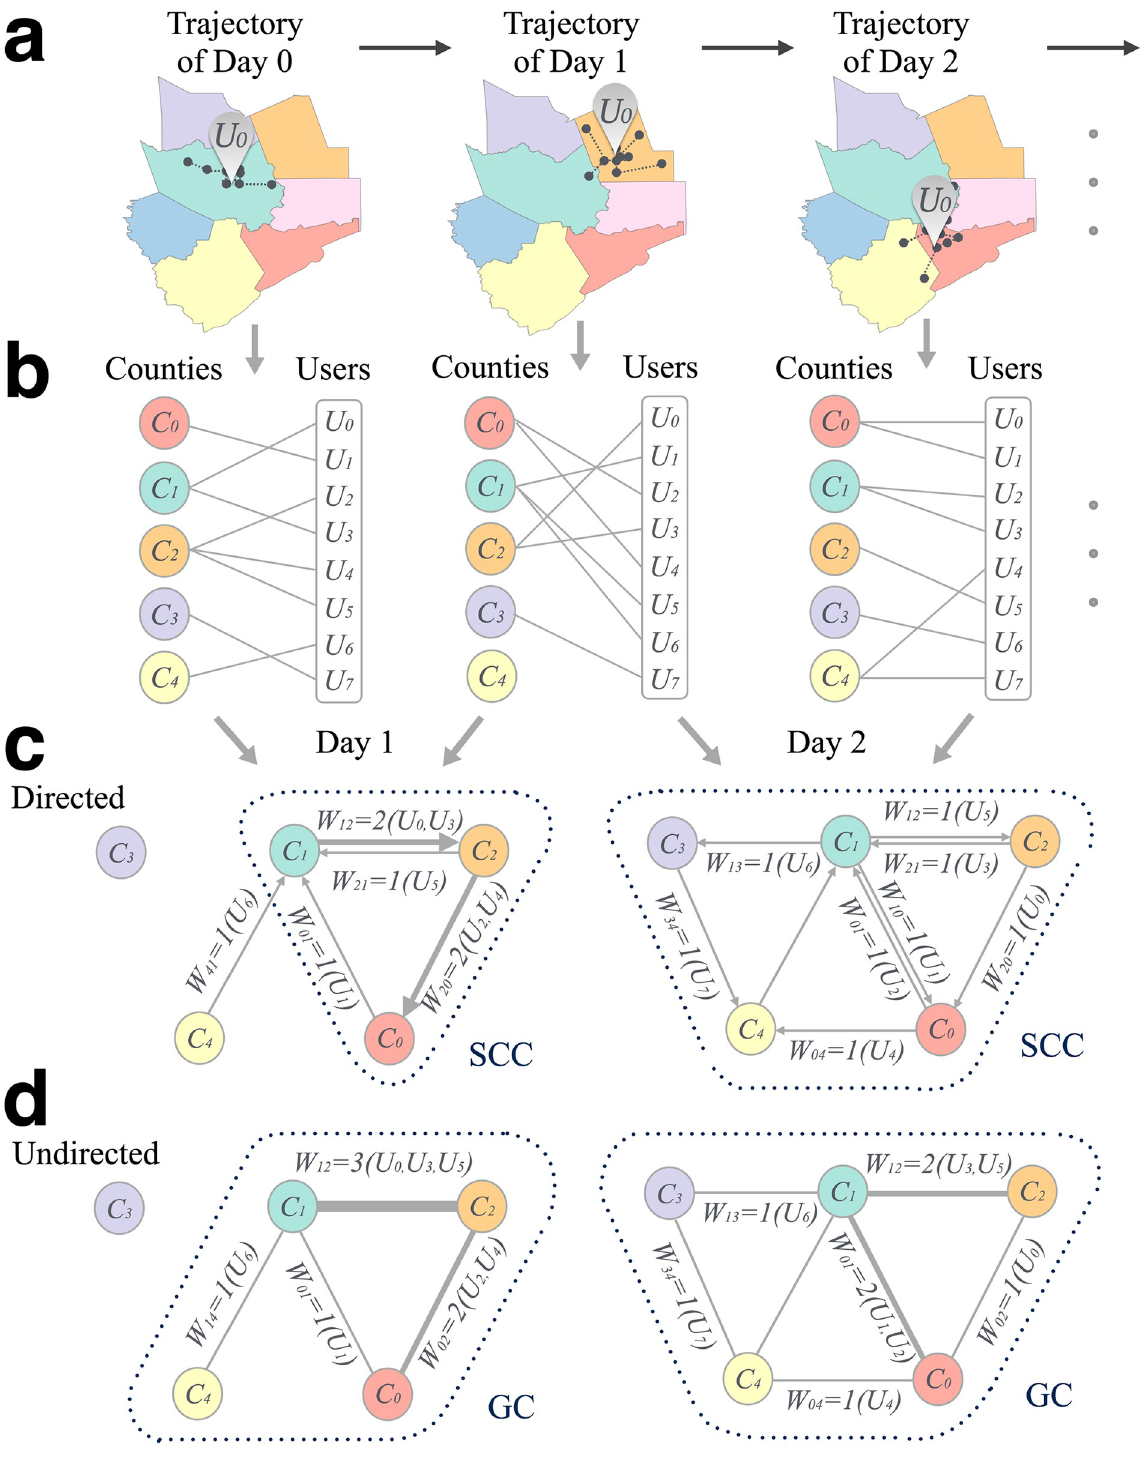
Fig 1. Mobility network. a , one user’s trajectories in two consecutive days. We compute the median of the longitudinal records as the prime location and geotag to the corresponding county. b , we iterate such process for all users and construct the bipartite graphs based on collective mobility. c , by comparison of two consecutive days’ bipartite graphs, we aggregate the inter-county travel information to a weighted and directed graph. The weights are the numbers of inter-county travelers. d , the undirected graph with weight as the sum between each pair of counties.